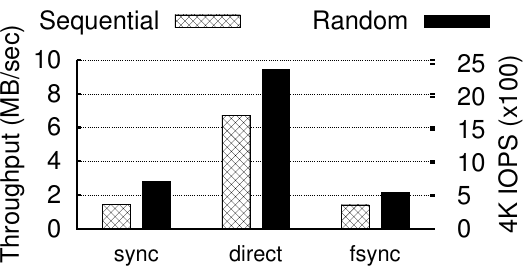
Figure 9. write() + fsync() , I/O on internal eMMC. Filesize: 512 MB; I/O-size: 4 KB [Samsung Galaxy S4, Android 4.2.2 (JB), /data partition, EXT4].